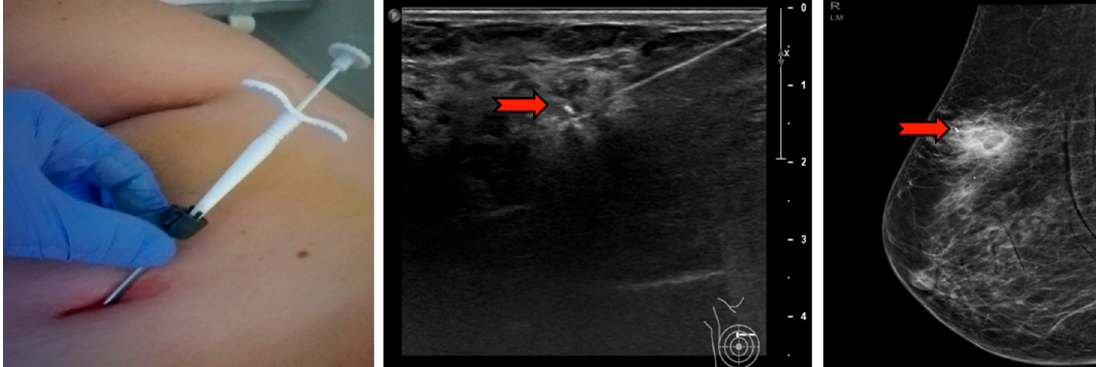
Figure 5. The needle and handpiece extraction and subsequent insertion of the localizing clip in the cannula left in the biopsy site. The red arrow indicates the clip in mammography and ultrasound that will be visible in follow ‐ ups for up to 6 months.